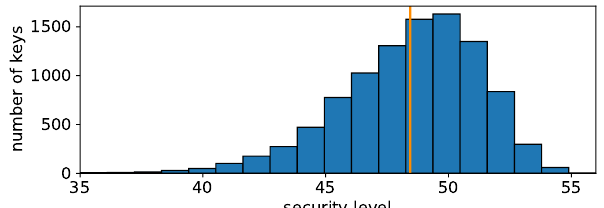
Figure 23: Histogram of security levels after template attacks on 10k keys using 100 traces per key on STM32 hardware DES accelerator. The average security level, marked by an orange line, is at 48.4